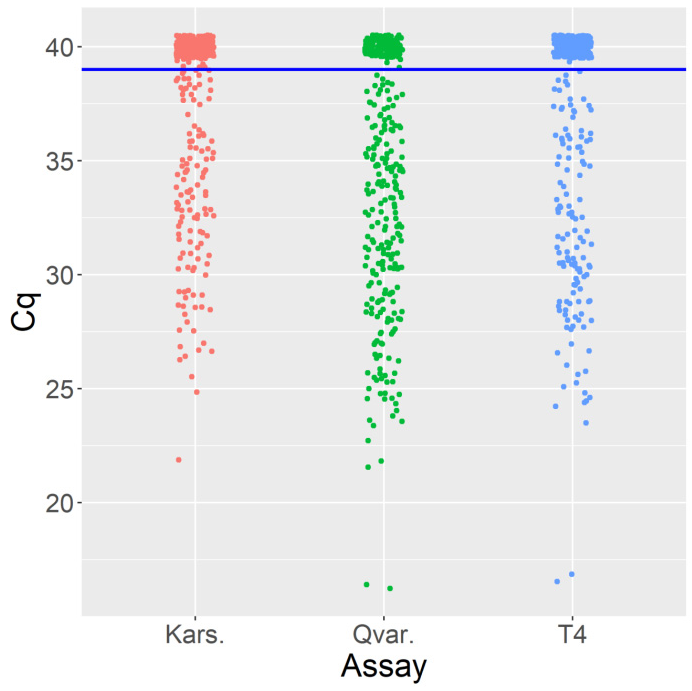
Figure 1. Cq values distribution plot of 185 clinical corneal samples with Kars assay (red), Qvar assay (green), and T4 assay (blue). The individual Cq values of each assay are plotted to show an overall Cq pattern and the range of the Cq values. The Cq of negative samples were arbitrarily set at 40 for visualization purpose.